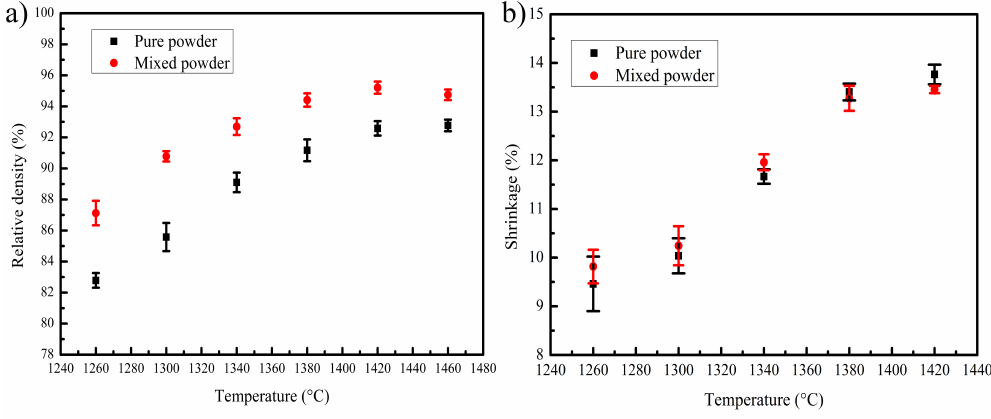
Figure 7. The relative density ( a ) and shrinkage ( b ) of the sintered samples at different sintering